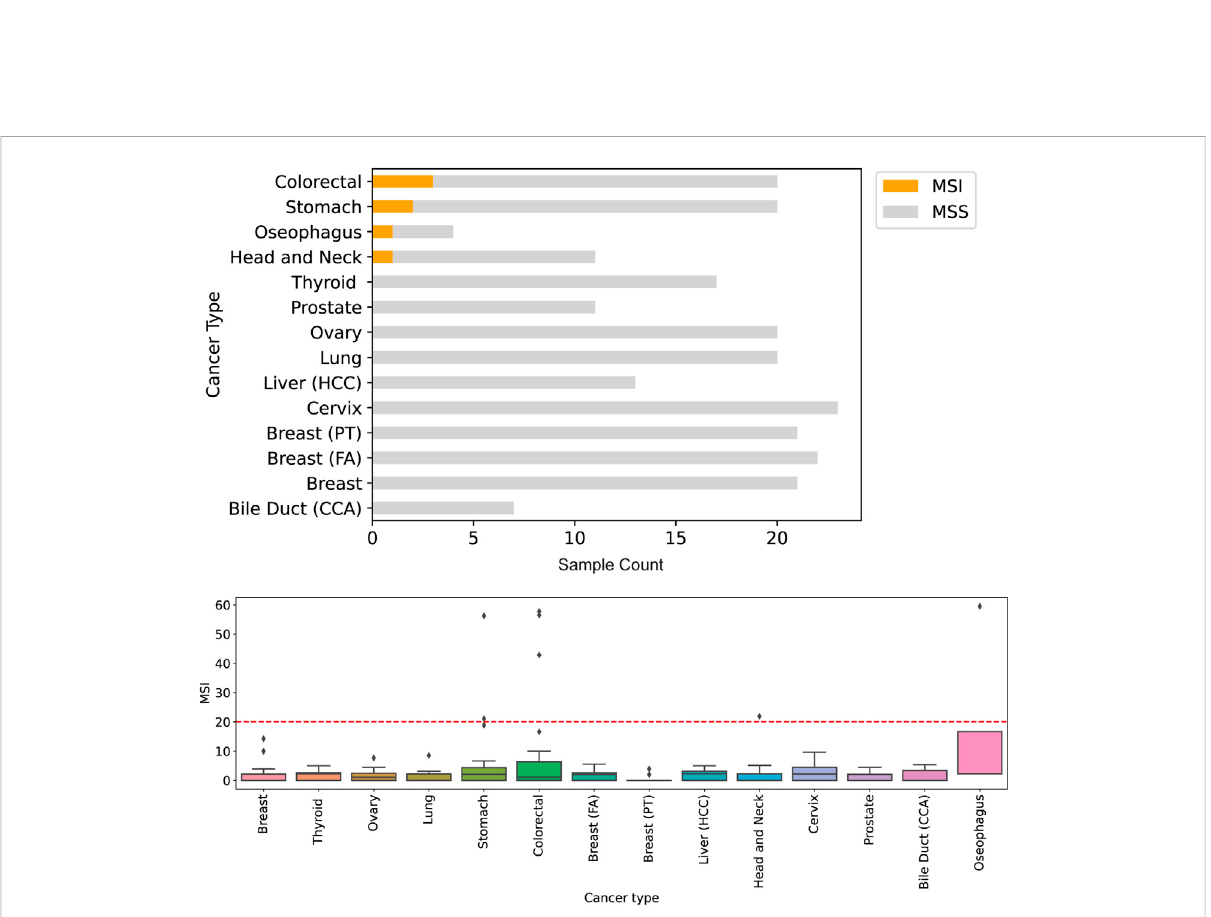
FIGURE 4 Detection of genomic instability in microsatellite regions of the genome. Across 212 samples pro fi led, seven were assessed to be microsatelite instable (MSI) by Asian Pan-Cancer Assay and Promega kit for MSI analysis. The highest number of microsatelite instable sites originate tissues of colorectal and gastric cancers.